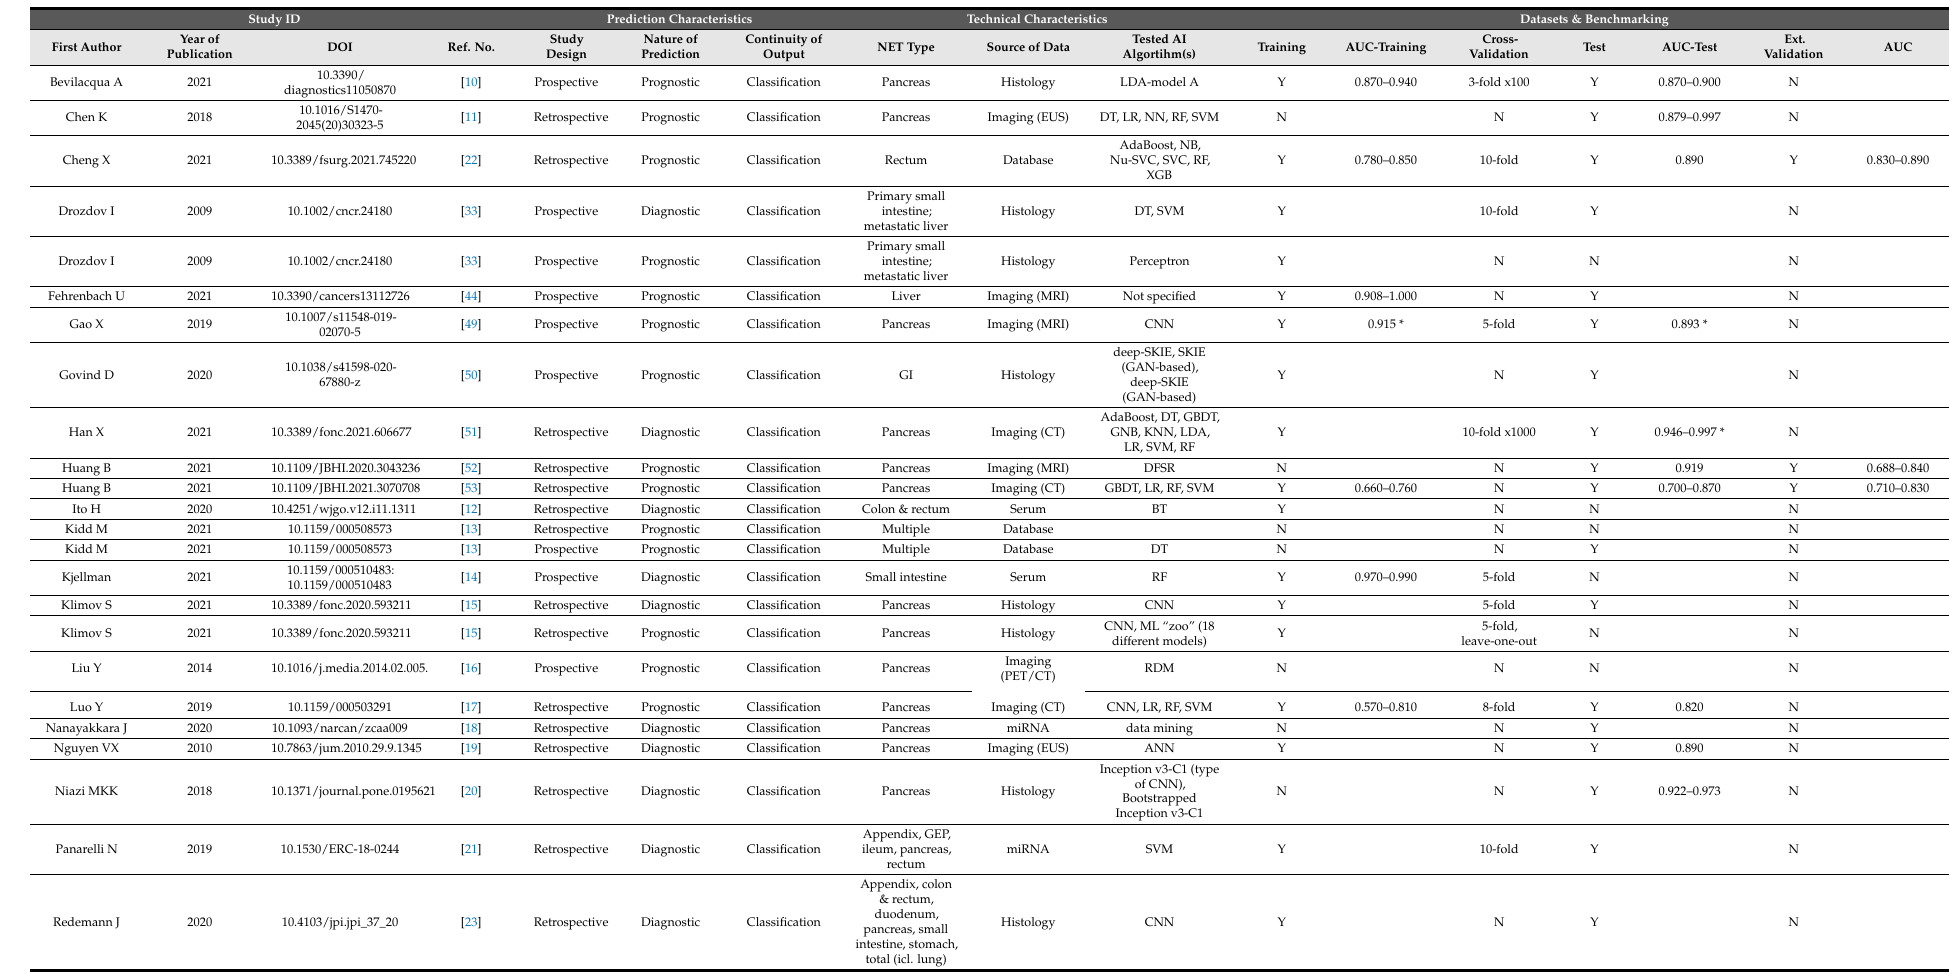
Table 2. Collective representation of the studies included in the present review, with respective prediction characteristics, technical characteristics, datasets and benchmarking. For reasons of conciseness, we have included only AUC of all the mentioned benchmarking